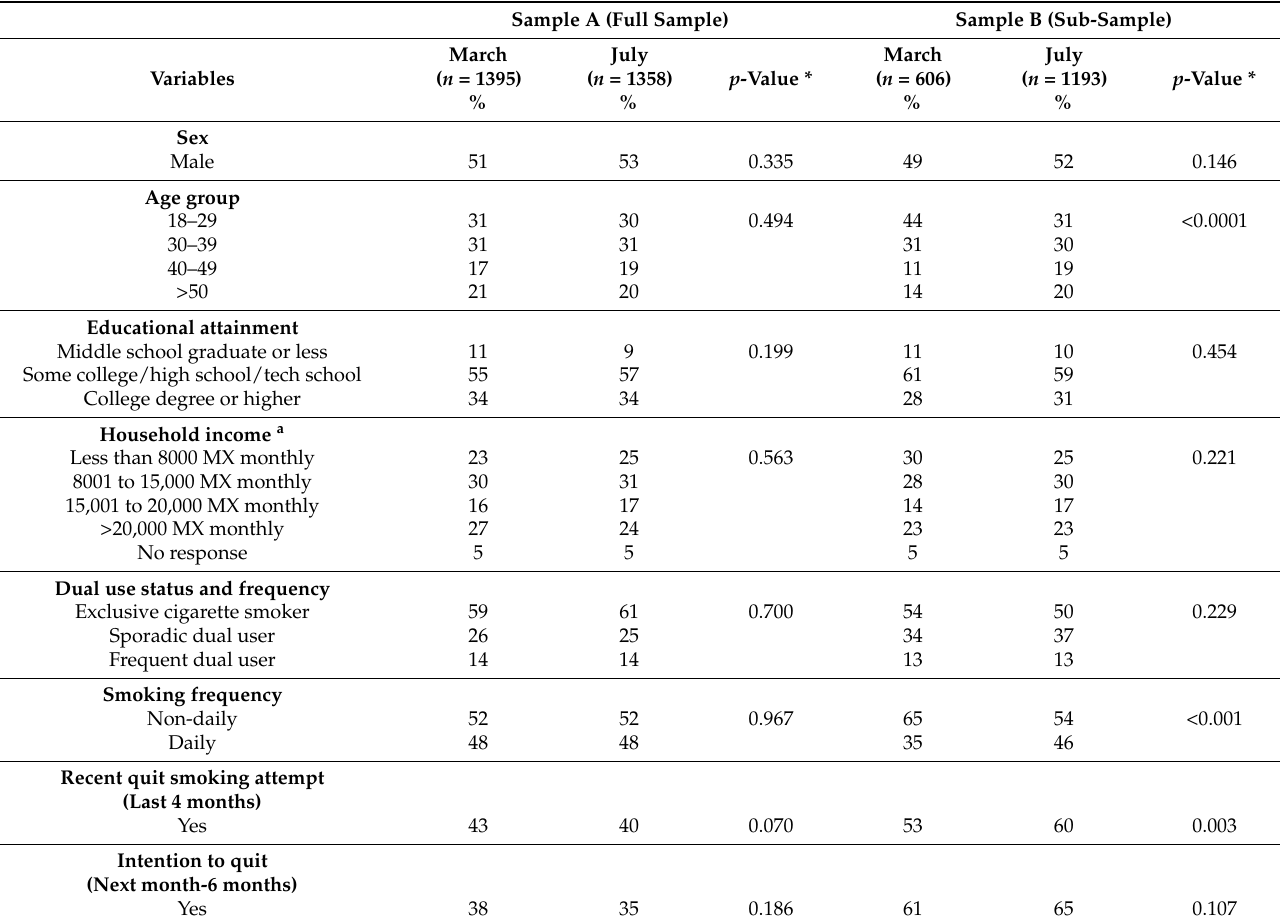
Table 1. Sample characteristics among Mexican adult smokers,